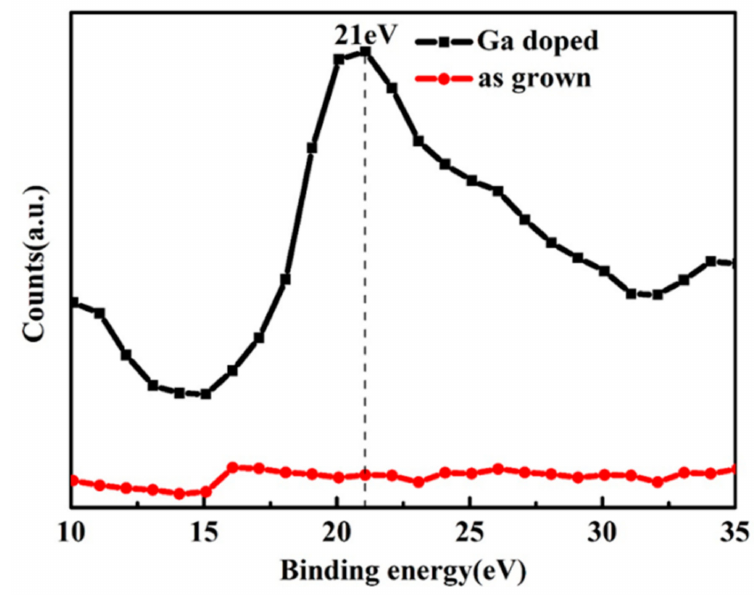
Figure 3. XPS survey spectrum of the ZnMgO sample with and without Ga